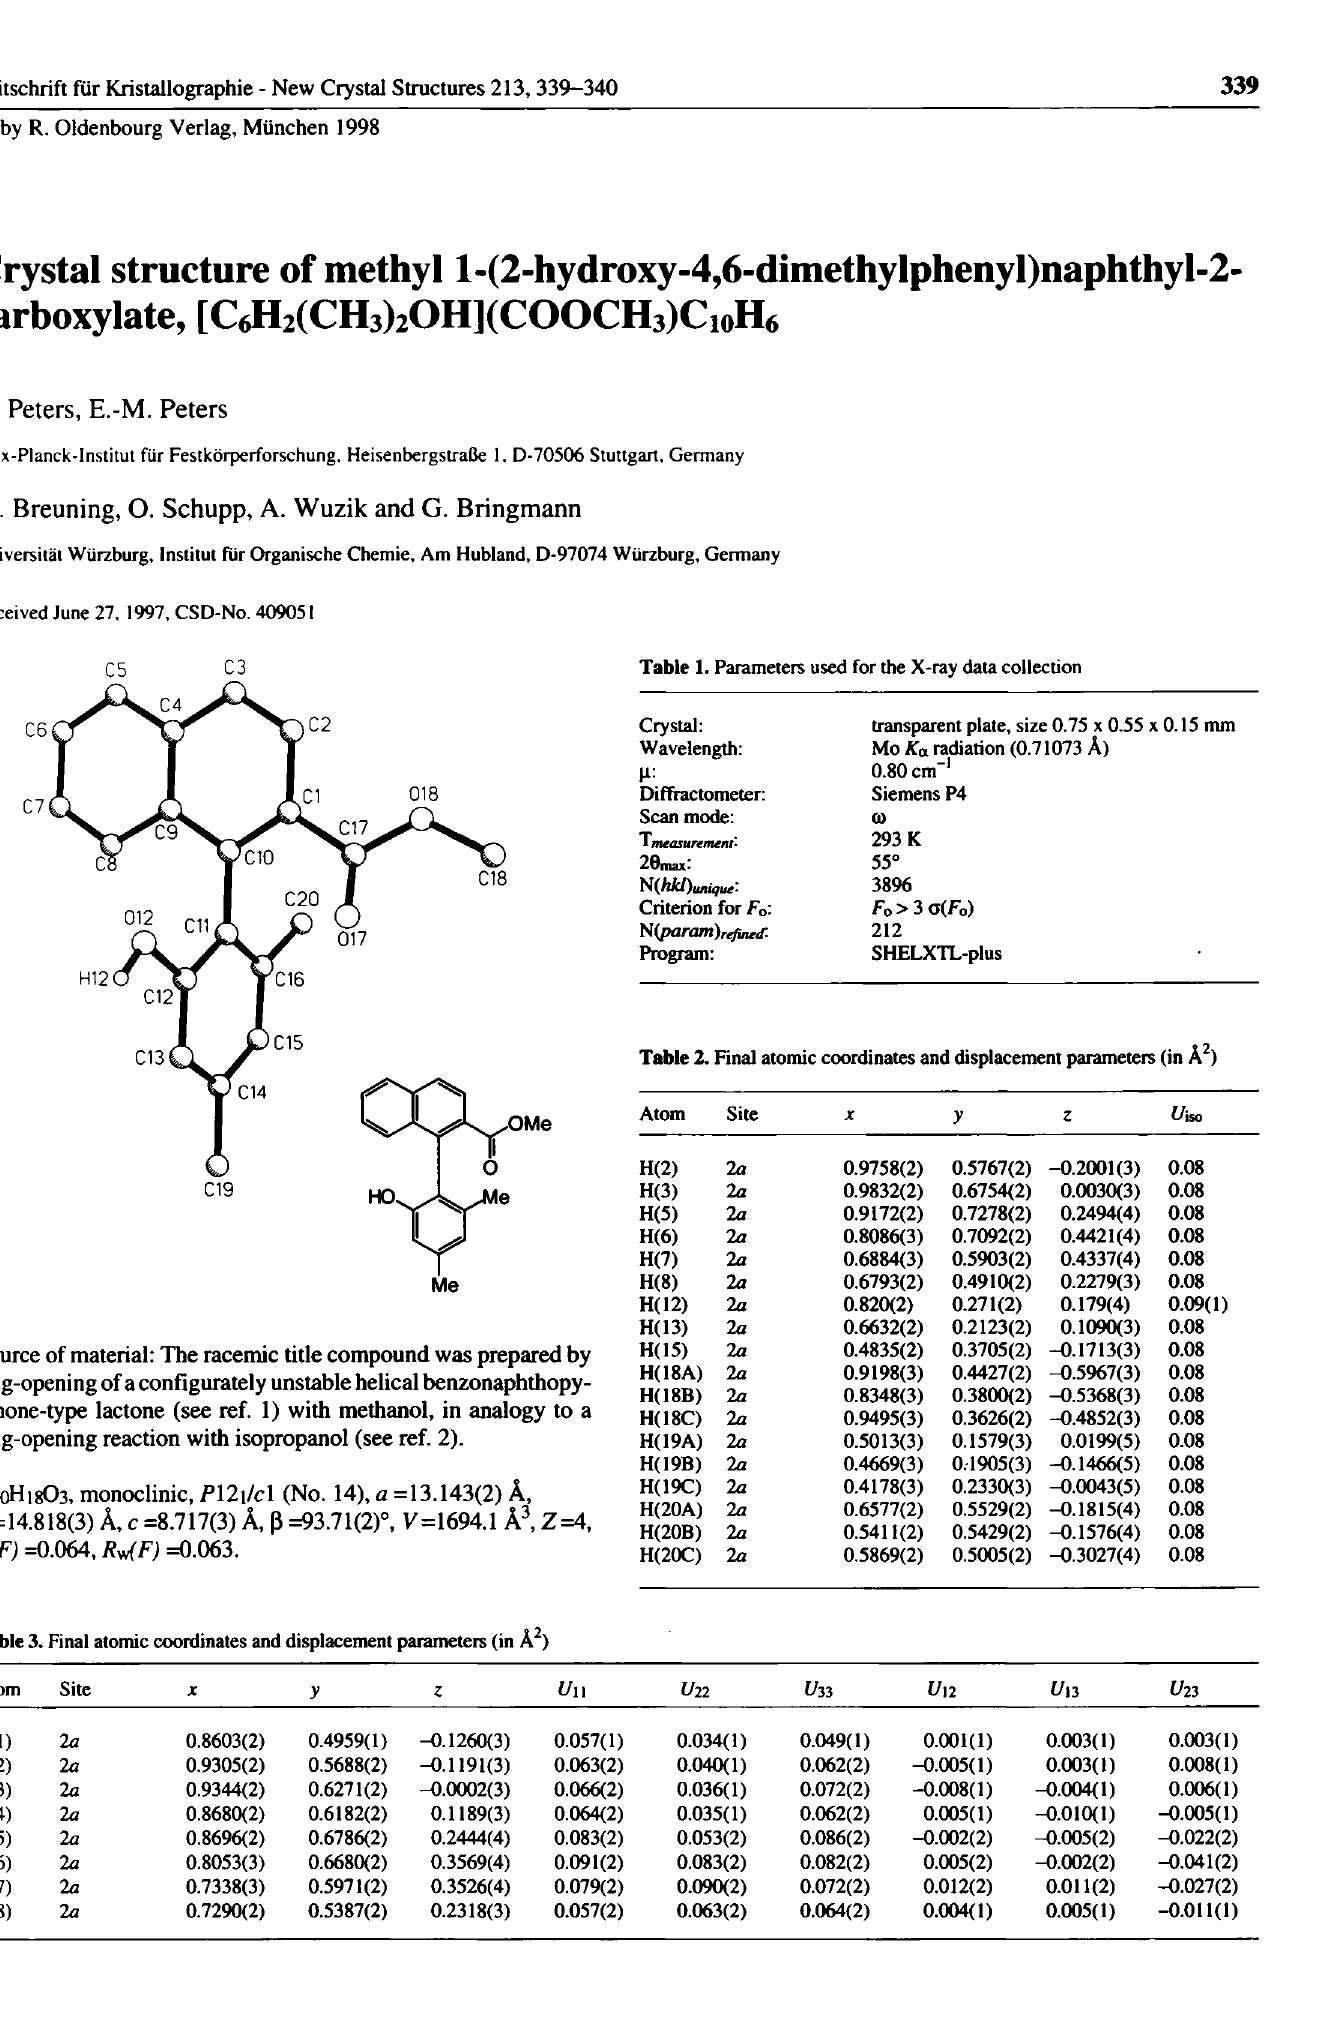
Table 3. Final atomic coordinates and displacement parameters (in Â^)